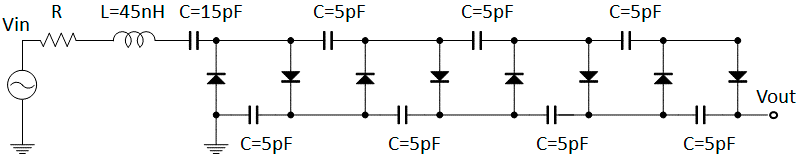
Figure 2. Schematic of the boost rectifier circuit. Vin: input voltage. Vout: output voltage. R: resistance. L: inductance. C: